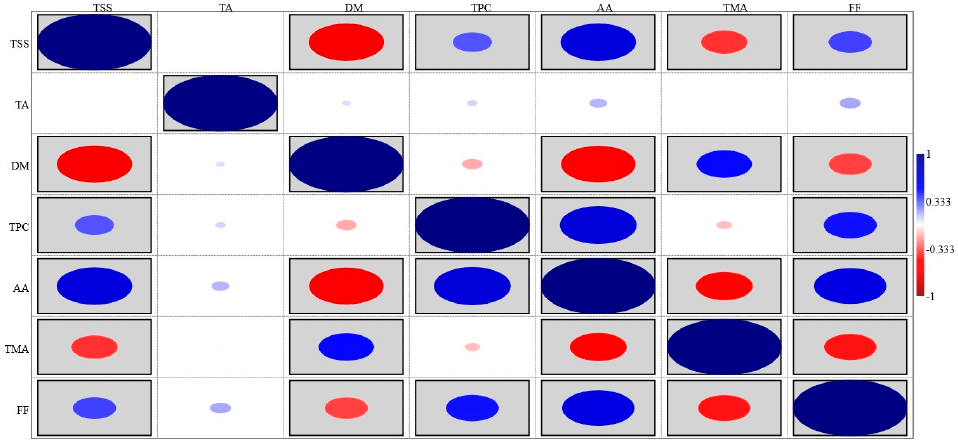
Figure 5. Spearman’s correlation coefficients between chemical traits: total soluble solid content (TSS), titratable acidity (TA), dry matter (DM), total phenolic content (TPC), antioxidant activity (AA), total anthocyanin content (TMA), and flesh firmness (FF).